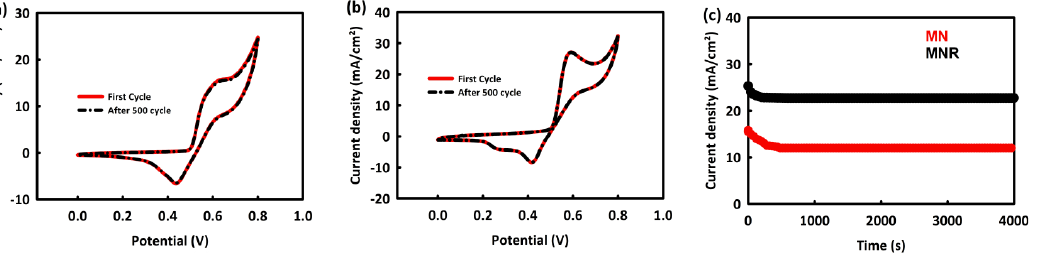
Figure 8. Cyclic stability of MN ( a ) and MNR ( b ) in MOR process after 500 consecutive CV and ( c ) chronoamperometry analyses of MN and MNR.